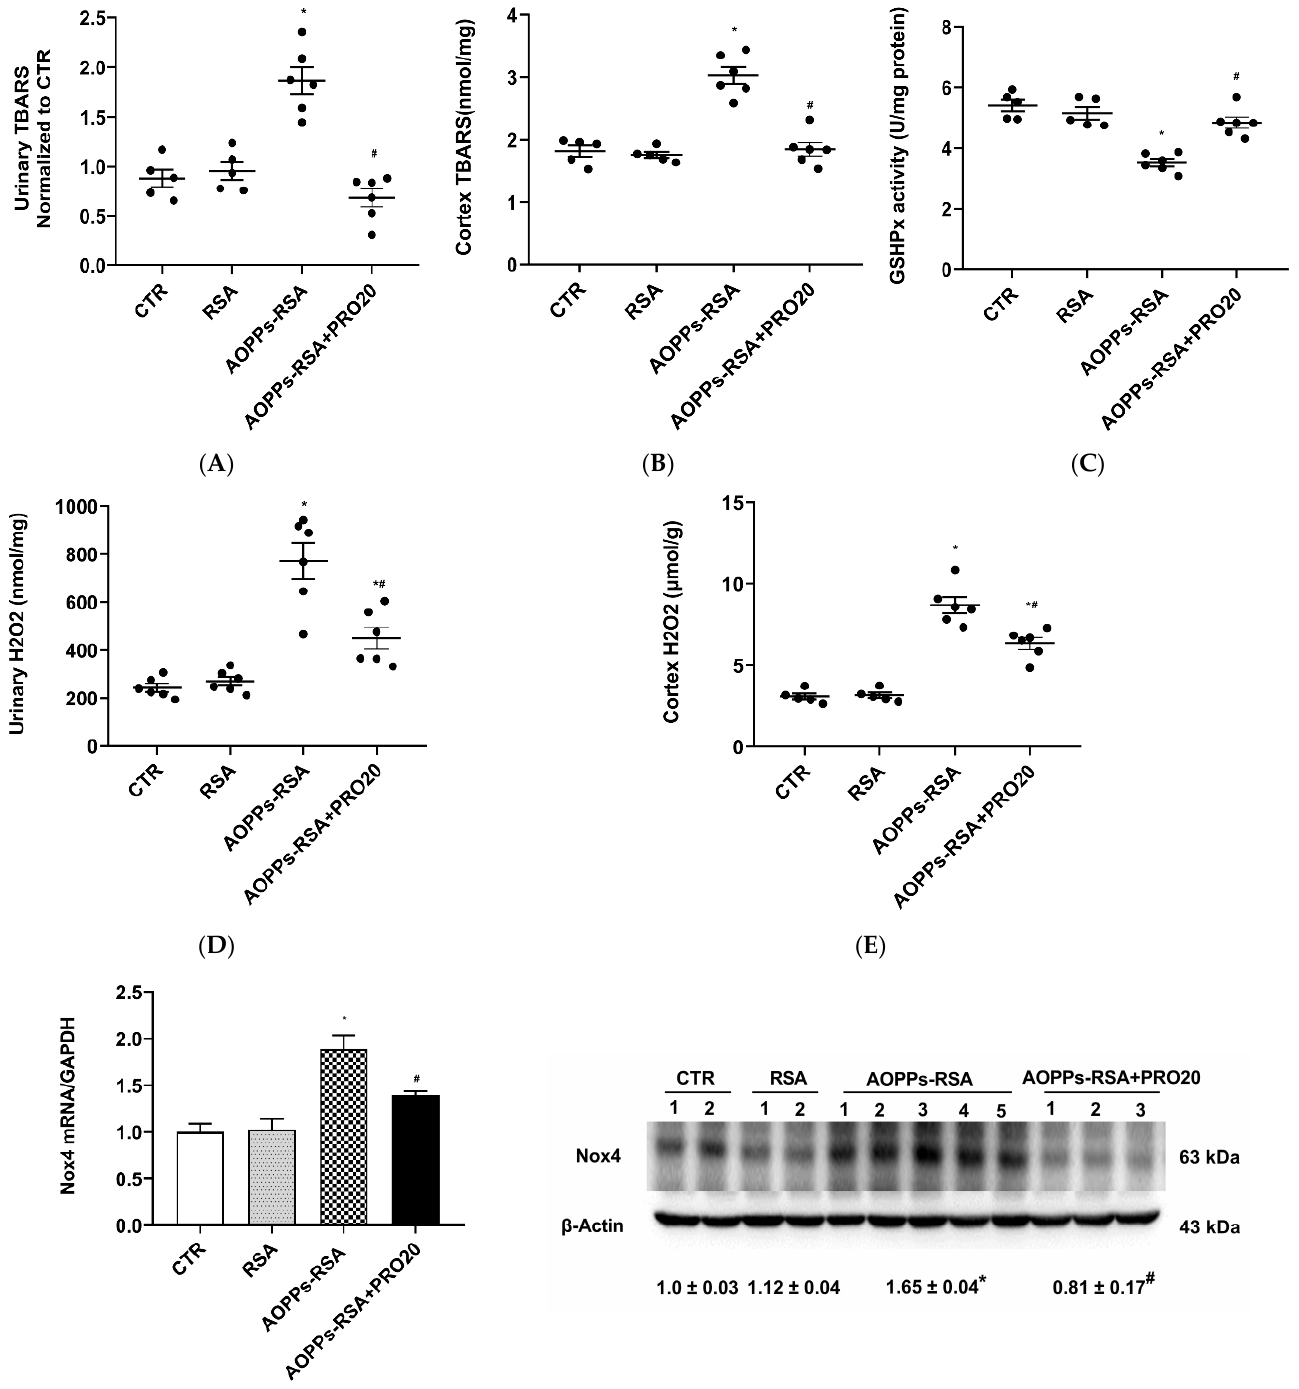
Figure 4. Administration of PRO20 reduced renal oxidative stresses induced by AOPP-RSA. Notes: ( A ) Urinary TBARS concentration; ( B ) renal cortex TBARS concentration; ( C ) renal cortex GSHPx activity; ( D ) urinary H 2 O 2 content; ( E ) renal cortex H 2 O 2 content; ( F ) mRNA levels of Nox4 were determined by RT-qPCR. All values were normalized against GAPDH expressions; ( G ) protein expression of Nox4 was performed by immunoblotting. The normalized quantitative data for β -actin are shown below each blot. Results are presented as mean ± SEM. There were 6 rats per group. * p < 0.05, compared to the CTR group; # p < 0.05, compared to the AOPPs-RSA group.